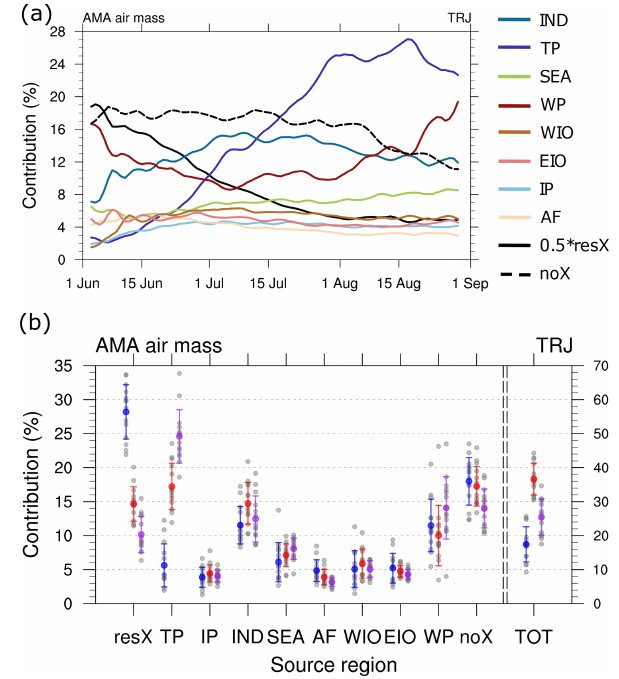
Figure 13. (a) Temporal evolution of source region contribution to the AMA air masses at 150hPa in the TRJ calculation. To fit the scale, the resX category was scaled by 0.5. All contribu- tions have been smoothed using 5d running means (weights of (cid:105) (cid:104) 1 , 2 , 3 , 2 , 1 ). (b) Contributions of PBL sources to the AMA at 9 9 9 9 9 150hPa for the TRJ calculation over 14 years split according to June (blue), July (red) and August (purple). The interannual standard de- viation is given as whiskers, and the individual years are included as grey dots. For TOT the total number of trajectories is given in units of 10 3 trajectories.